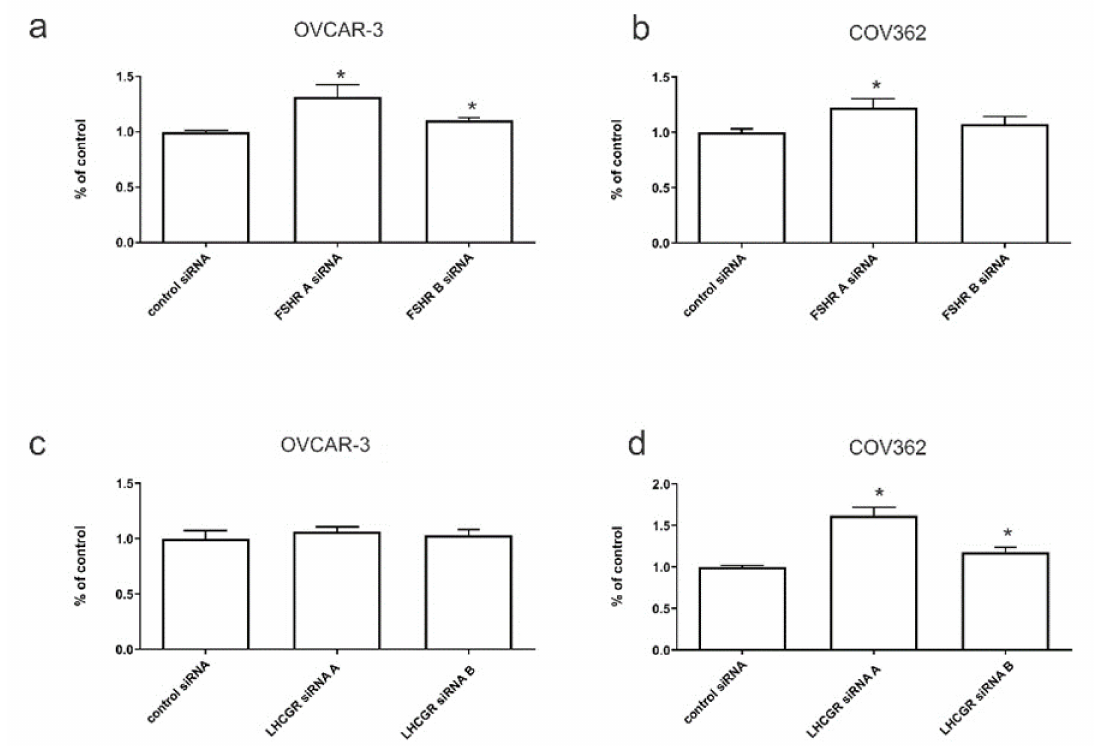
Figure 10. Effects of FSHR and LHCGR knockdown on serous ovarian cancer cell invasion in vitro. Ovarian cancer cells were treated with two independent FSHR (A and B) and LHCGR (A and B) siRNAs and negative control siRNA for 30 h. ( a ) OVCAR3 cell invasion, mean ± SEM from 3 independent experiments ( n = 11–12). ( b ) COV362 invasion, mean ± SEM from 3 independent experiments ( n = 10–12). ( c ) OVCAR3 invasion, mean ± SEM from 4 independent experiments ( n = 10–16). ( d ) COV362 cell invasion, mean ± SEM from 2 independent experiments ( n = 8). Data are shown as a percentage of the negative control siRNA. * p < 0.05, significantly different from control, Student’s